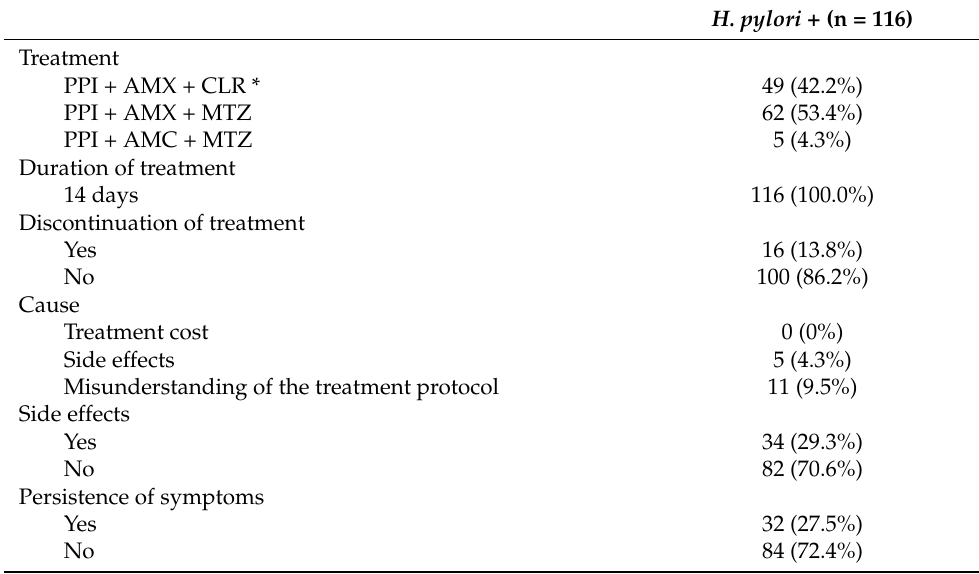
Table 5. Eradication scheme and therapy compliance in H. pylori -positive patients.